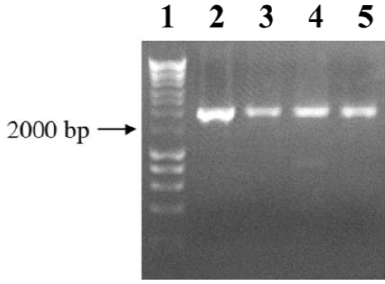
Figure 7. PCR amplification using oligonucleotides pair F1 eptC -R1 eptC and DNA template from P. mirabilis strains R110 (Lane 2), 50/57 (Lane 3), 51/57 (Lane 4), and TG83 (Lane 5). Lane 1, molecular weight standard.